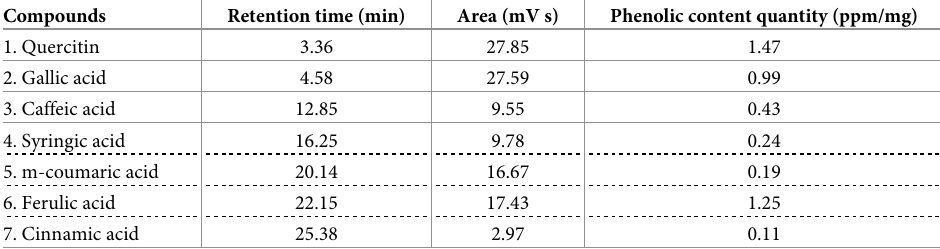
Table 2. The qualitative and quantitative analysis of phenolic compounds in the Euphorbia nivulia Buch.-Ham. crude extract using HPLC.